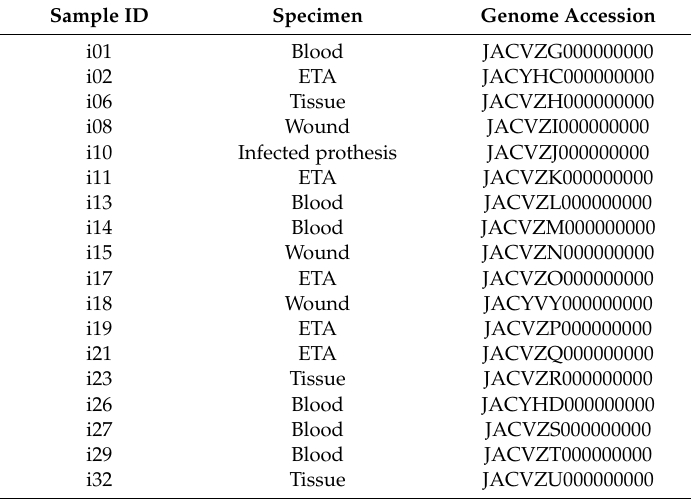
Table 2. NCBI accession numbers of the 18 sequenced